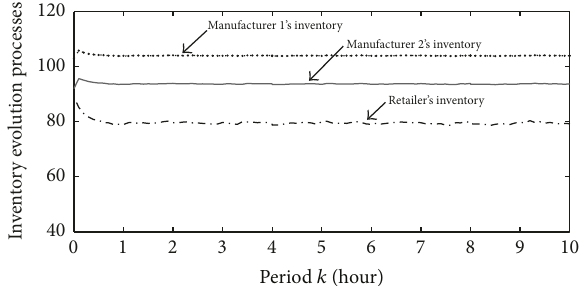
Figure 3: Evolution processes of inventories with cost optimization strategy ( ×10 3 pairs).